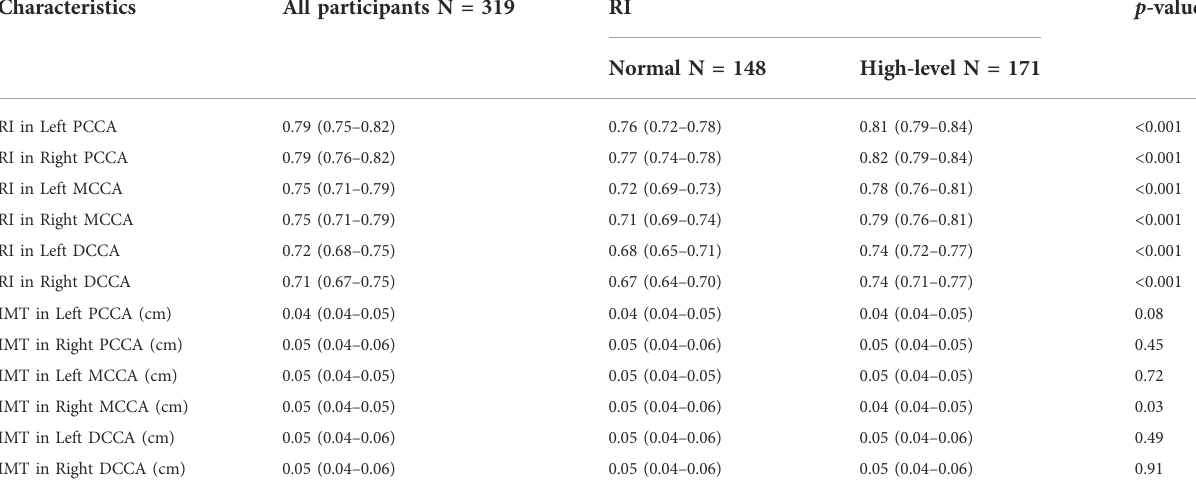
TABLE 2 Statistics of CUS parameters for participants in the normal RI group and the high-level RI group. Characteristics All participants N = 319